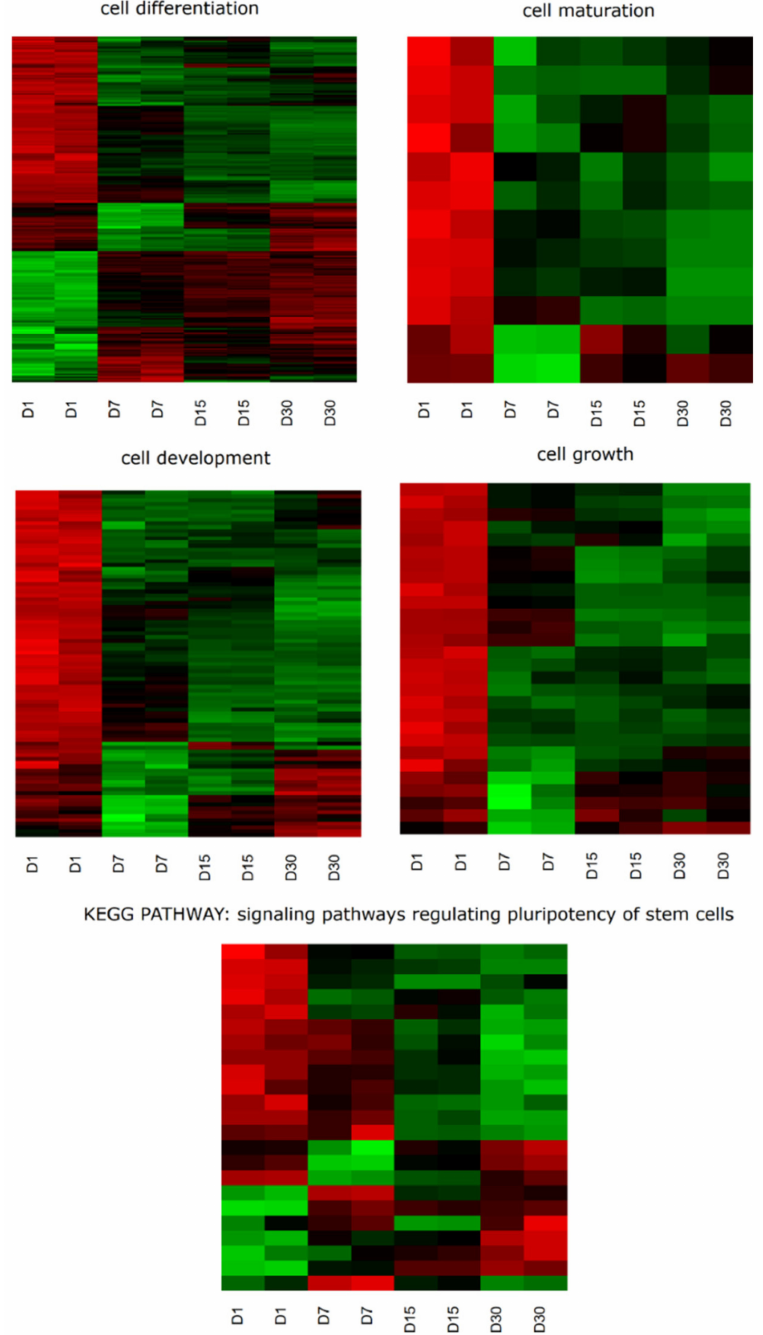
Figure 1. Heatmap representation of differentially expressed genes belonging to the ‘cell differentia- tion’, ‘cell growth’, ‘cell maturation’ and ‘cell development’ Gene Ontology biological process terms, as well as the ‘signaling pathways regulating pluripotency of stem cells’ KEGG pathway. The results obtained from microarray analysis are presented by a color signal intensity scale (green-upregulation; red-downregulation). The signal intensity log2 values for each individual gene were changed to a Row Z-Score scale, ranging from − 2, minimum expression to +2, maximum expression for a particular gene. KEGG = Kyoto Encyclopedia of Genes and Genomes; D, day of